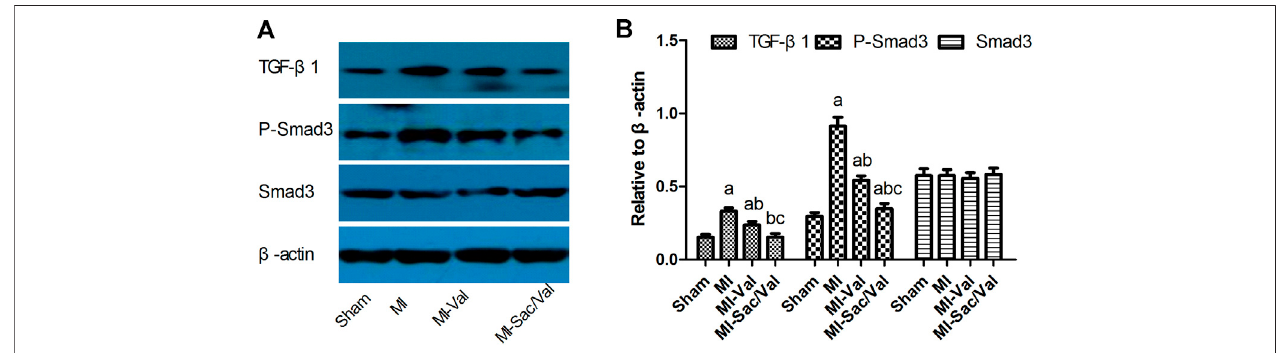
FIGURE 3 | Effects of sacubitril/valsartan on myocardial TGF- β 1, Smad3 and p-Smad3 protein expression in rats after myocardial infarction. (A) Representive immunoblots of protein TGF- β 1, p-Smad3 and Smad3 in infarcted myocardium. (B) Bars represent protein quanti fi cation of TGF- β 1, p-Smad3 and Smad3 relative to β -actin.TGF- β 1,transforminggrowthfactor- β 1;MI,myocardialinfaction;Val,valsartan;Sac/Val,sacubitril/valsartan.Resultsaremean ± SD( n (cid:1) 8);a P < 0.05 vs. Sham; b P < 0.05 vs. MI; c P < 0.05 vs.